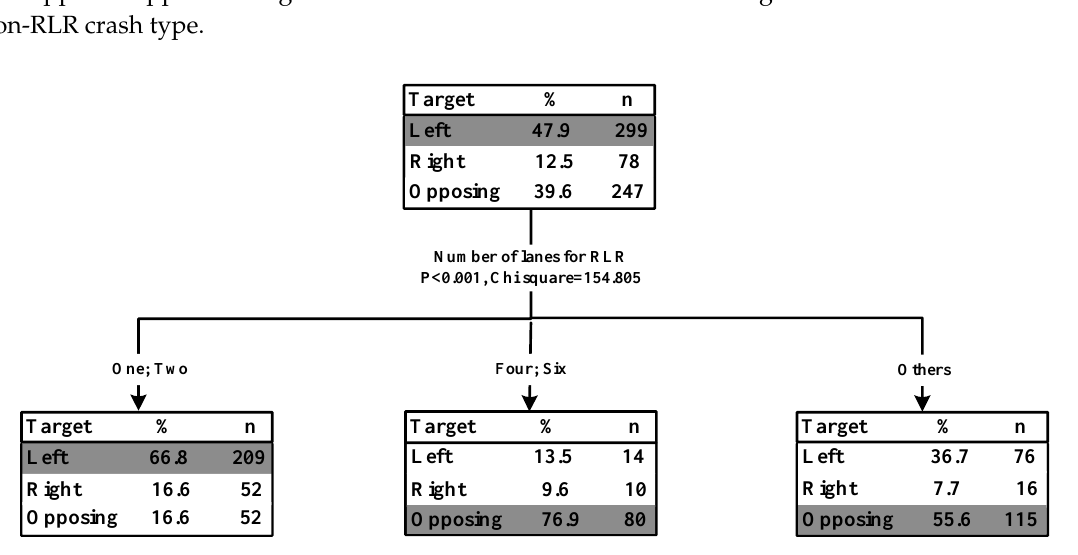
Figure 5. Tree model for RLR crash type #3 LT RLR and GS non-RLR.